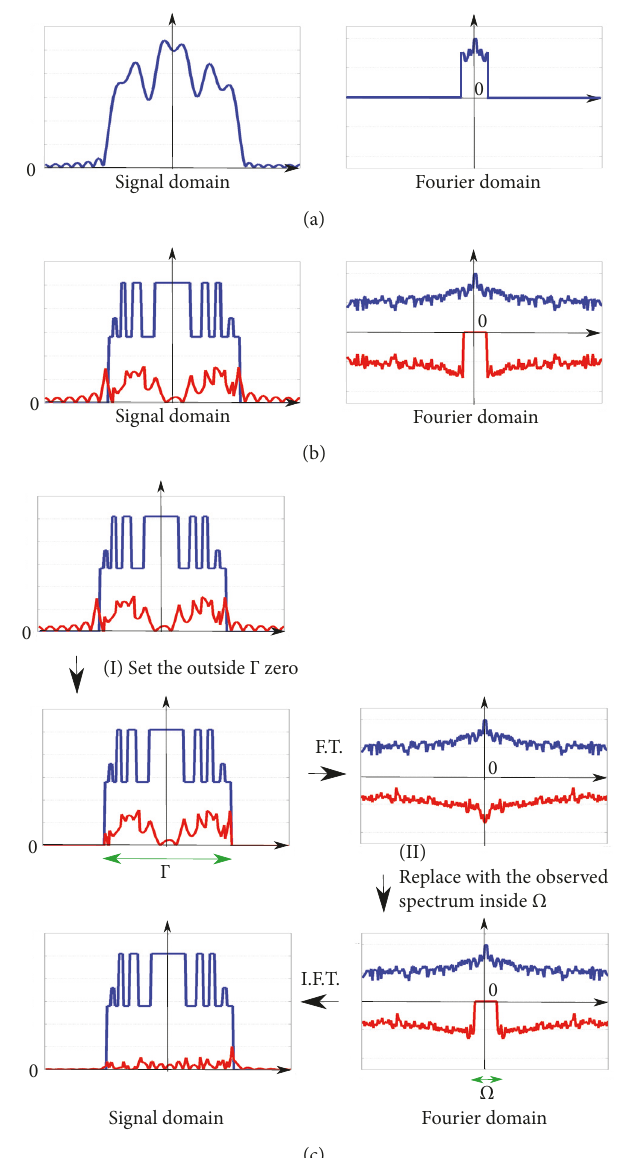
Figure 2: Illustration of the Gerchberg algorithm. (a) The observed image (left) and its spectrum (right). (b) The interpretation of (a). The observed image is the sum of the true signal/spectrum (blue line) and the error signal/spectrum (red line). (c) The procedure followed by the algorithm. The error spectrum is reduced by iterating in both the signal and Fourier